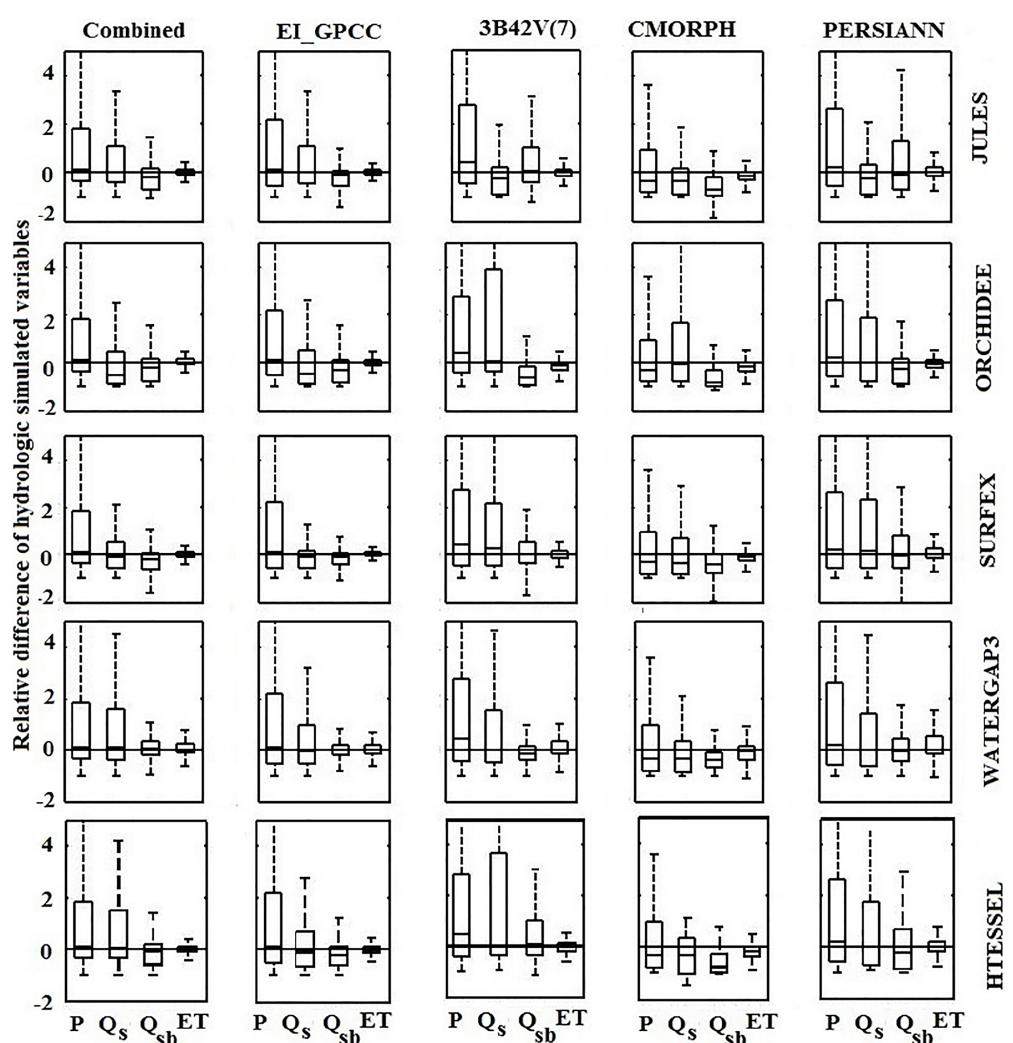
Figure 8. Relative difference presented for the various products and models at daily scale. In each box, the central mark is the median, and the edges are the first and third